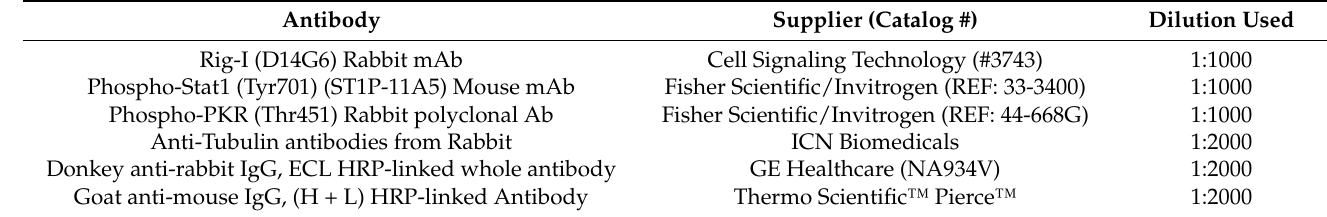
Table 1. Antibodies used in this